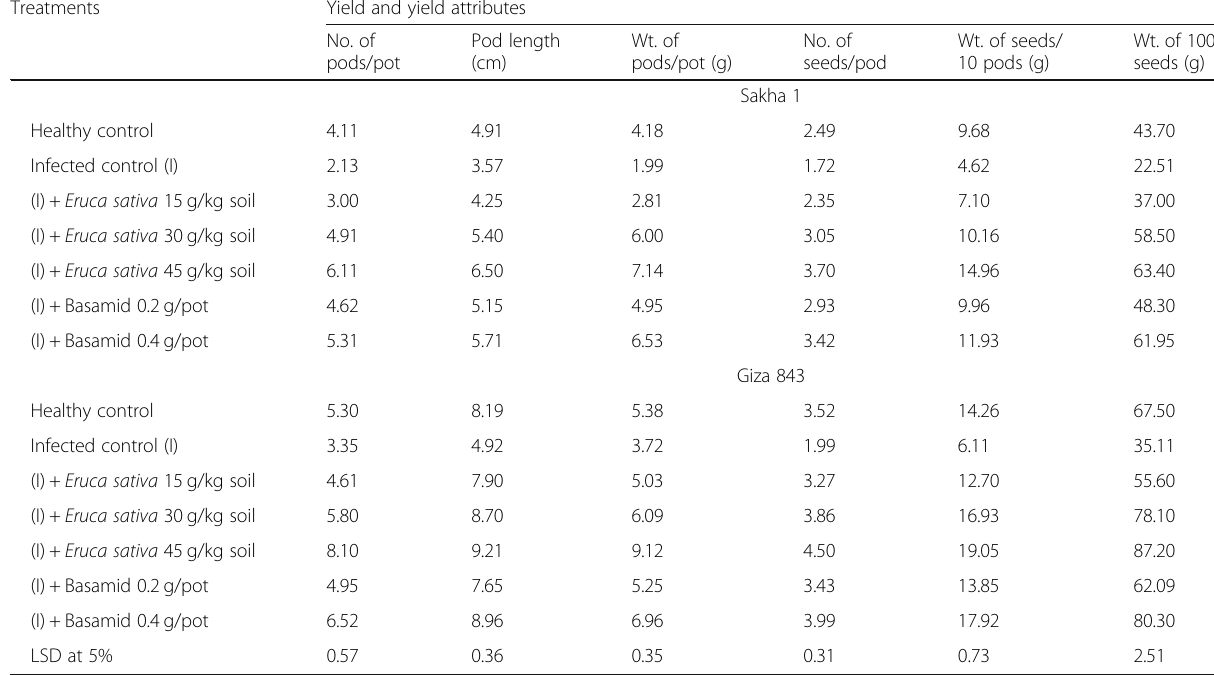
Table 4 Effect of different concentrations of Eruca sativa L. seed powder and Basamid herbicide on yield and yield attributes of two Vicia faba L. cultivars at harvest (combined analysis of two seasons) Treatments Yield and yield attributes No. of Pod length pods/pot (cm) Healthy control Infected control (I)